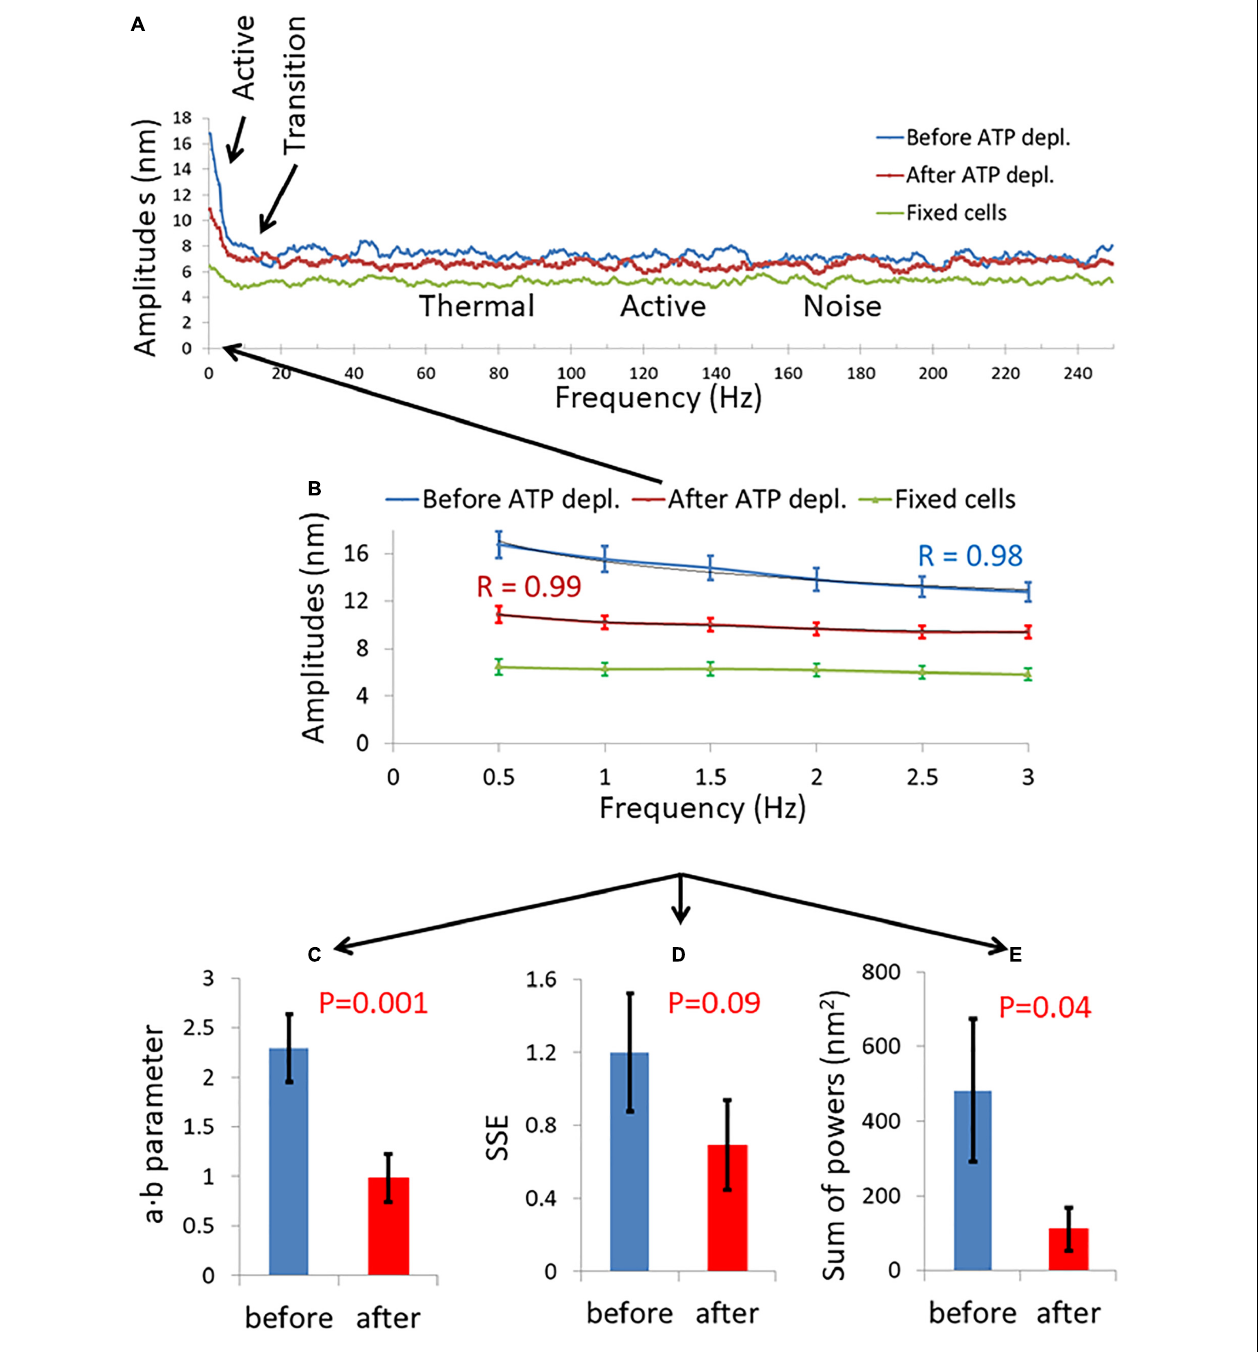
FIGURE 7 | Amplitude spectral density (ASD) and power spectral density (PSD) analysis results of live cells diameter fluctuations before and after adenosine triphosphate (ATP) depletion. (A) Average ASD analysis results in cells before (blue line) and after (red line) ATP depletion. Control average ASD results of 20 fixed cells are also presented (green line). Specific ranges of frequencies according to their dominant mechanism of fluctuations are highlighted. N = 14 cells. (B) Focusing on ASD results in the frequencies range of 0–3 Hz out of the total frequencies range presented in image (A) . R values for the power fit to the ASD results are also presented. (C) Average power fit parameter a · b results of the ASD analysis presented in image (B) before and after ATP depletion. (D) Average power fit parameter sum of squared errors (SSE) results of the ASD analysis presented in image (B) before and after ATP depletion. (E) Average power fit parameter “Sum of powers” results of the PSD analysis before and after ATP depletion. Error bars in (B–E) are SEM.